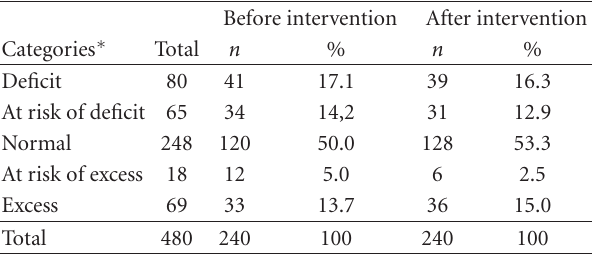
Table 2: Classification of children according to nutritional status, by combination of indexes before and after nutritional education